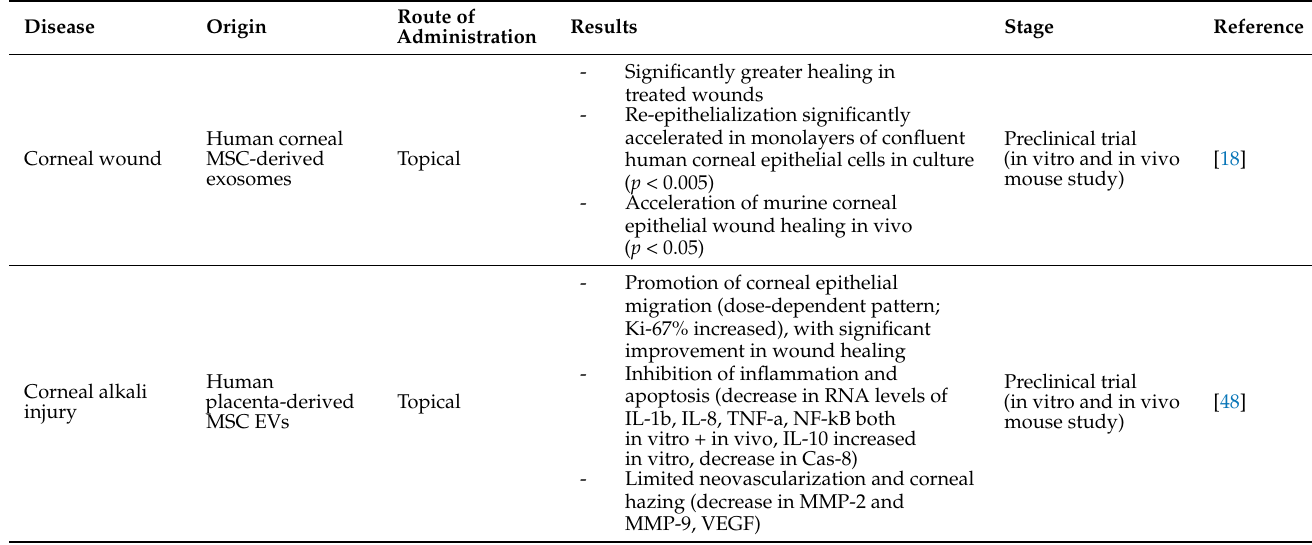
Table 1. MSC-derived exosomes in anterior segment diseases and